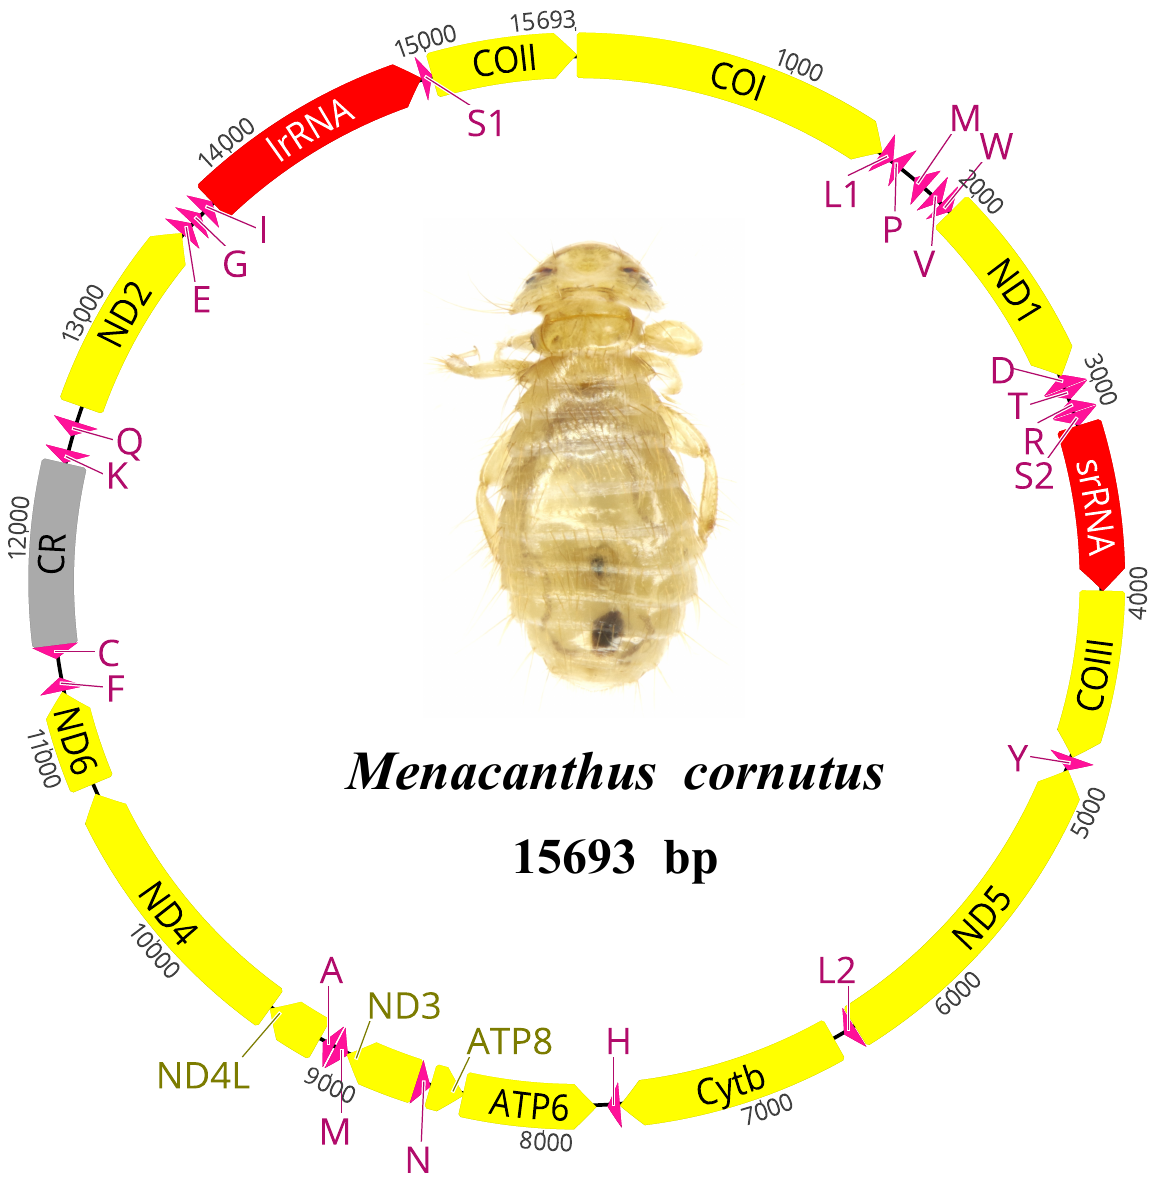
Figure 1. The mitochondrial genome of Menacanthus cornutus . The arrows indicate the direction of gene transcription. The yellow, pink, red, and gray colors indicate the regions of PCGs, tRNA genes, rRNA genes, and control regions, respectively. Abbreviations: ATP6 and ATP8 , adenosine triphosphate (ATP) synthase subunits 6 and 8; COI–COIII , cytochrome C oxidase subunits I-III; CytB , cytochrome b; ND1-ND6 and ND4L , nicotinamide adenine dinucleotide hydrogen (NADH) dehydrogenase subunits 1-6 and 4L; lrRNA and srRNA , large and small rRNA subunits; The tRNA genes are indicated with their one-letter corresponding amino acids; CR, control